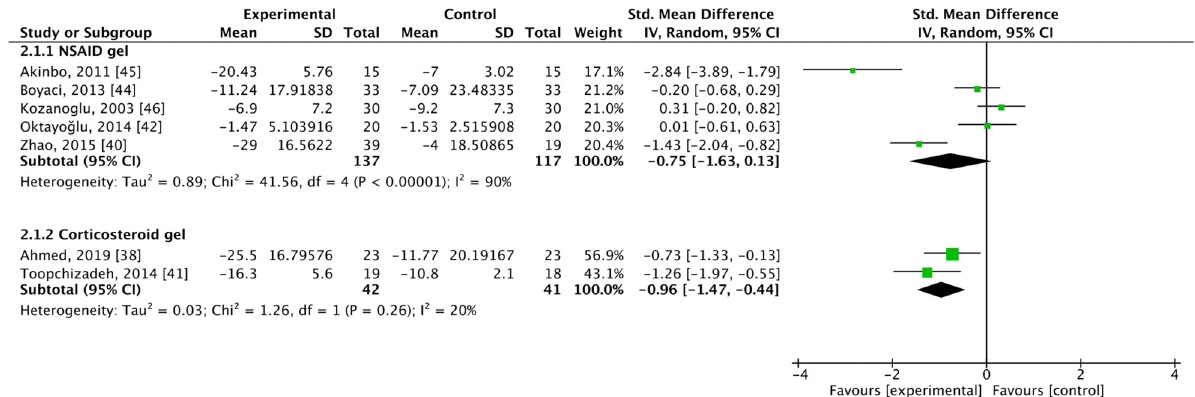
Figure 4. Forest plot for changes from baseline determined using the Western Ontario and McMaster Universities Arthritis Index (WOMAC) function scores. SD, standard deviation; CI, confidence interval.